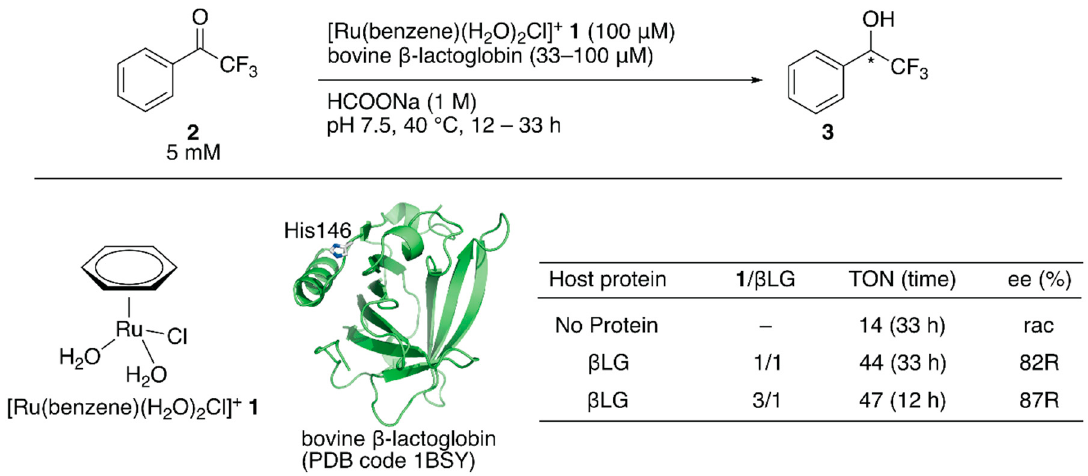
Figure 1. Transfer hydrogenation of ketones catalyzed by 1 · β LG with formate salt as a hydride source. Adapted from [31].